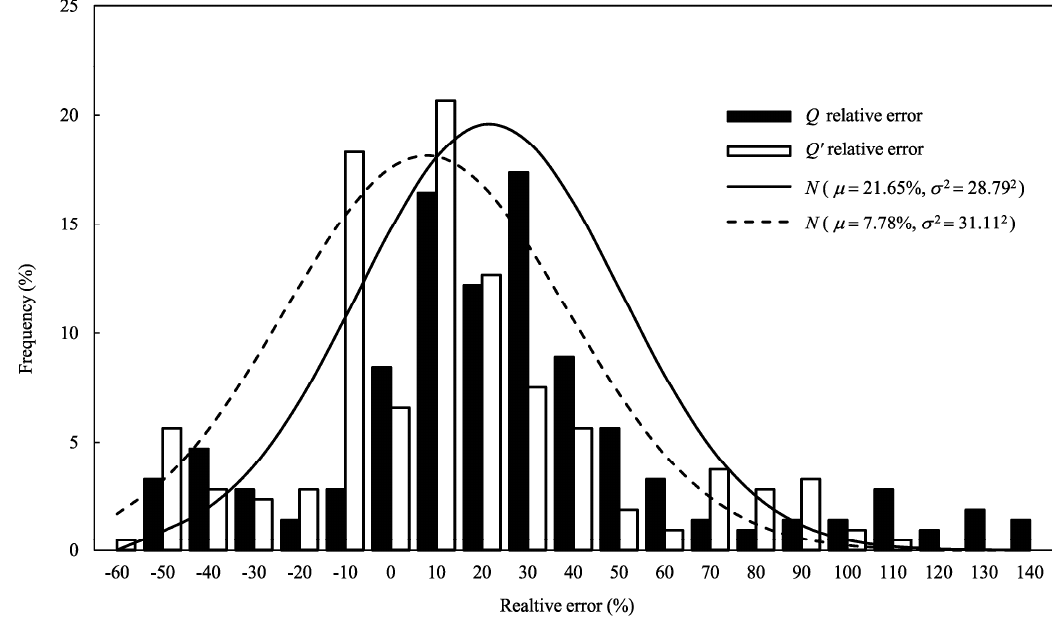
Figure 11. Frequency distribution of computed discharge relative error.